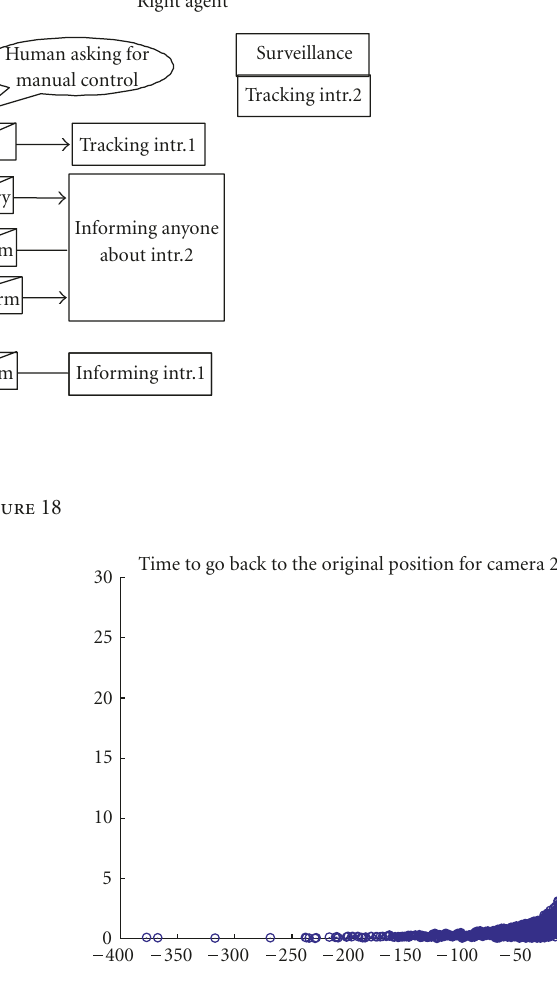
Figure 19: Seconds remaining for the left agent as a function of the velocity (pixels per second) of the target detected by the right agent.